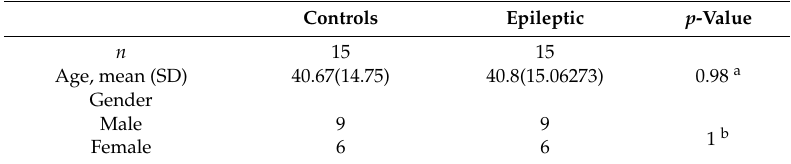
Table 1. Results of the univariate analysis on important demographic factors.